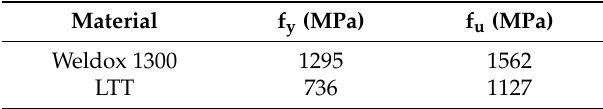
Table 2. Yield and tensile strengths of base material and all-weld